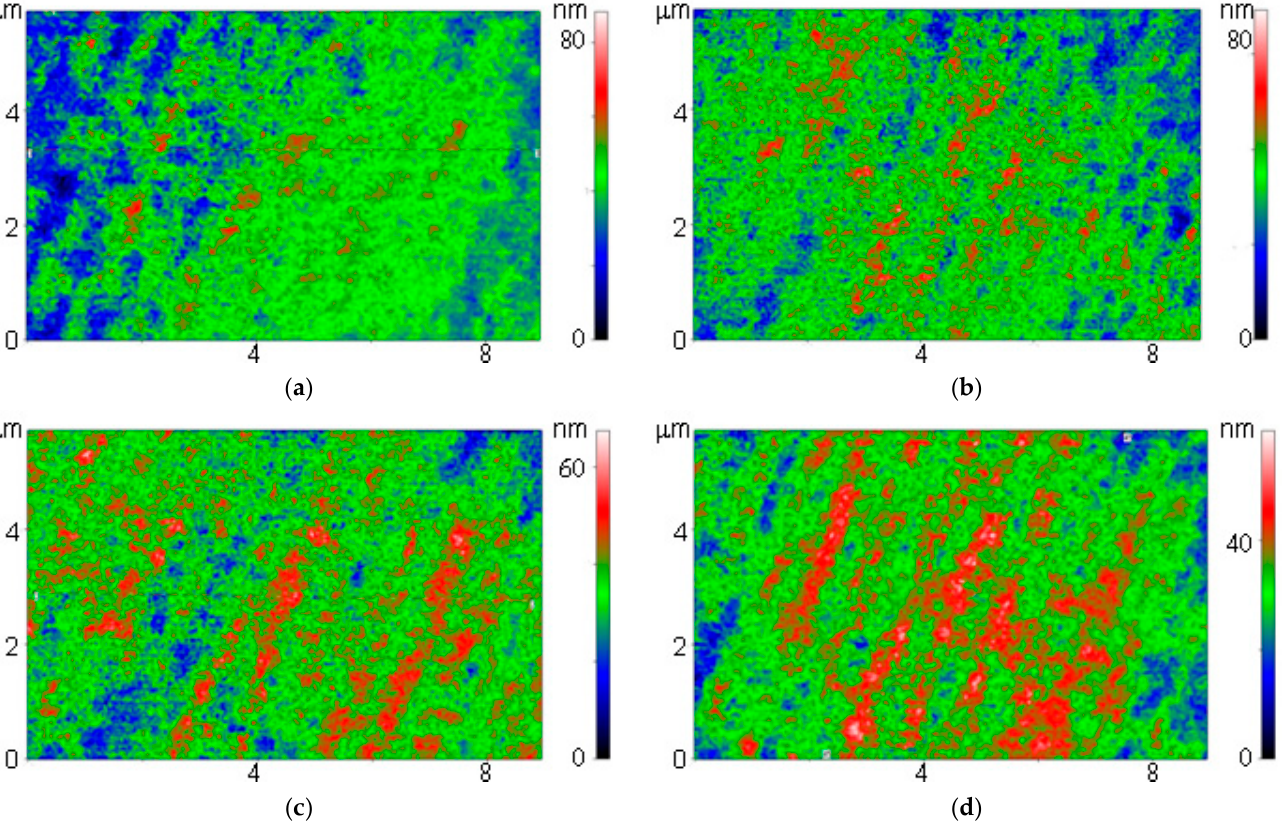
Figure 4. Images obtained on a polymer without fullerenes ( a ) and polymers with fullerenes at a concentration of 0.001% ( b ), 0.01% ( c ) and 0.1% ( d ) using a modulation interference microscope.